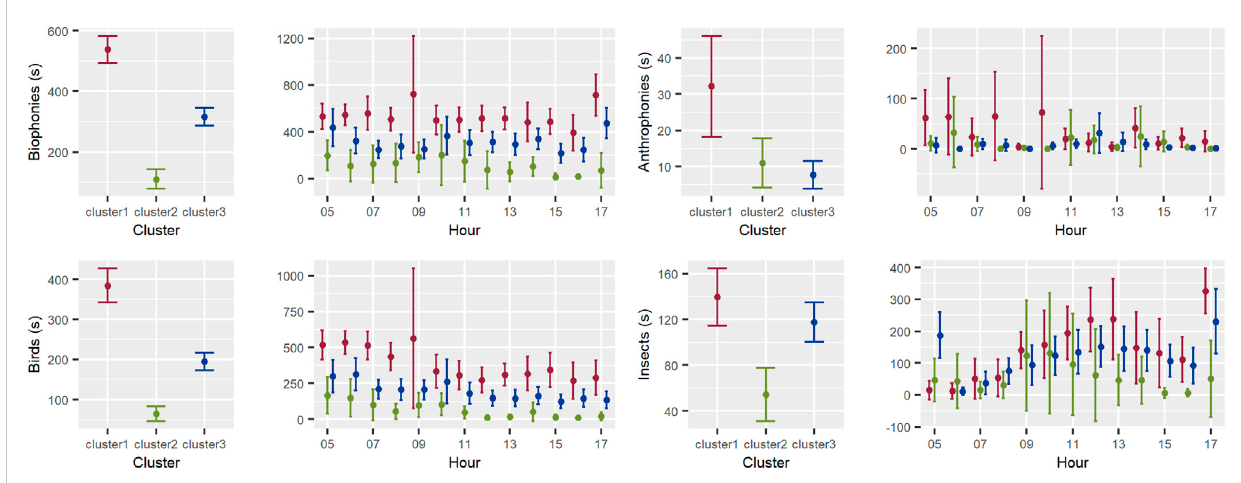
Distributionperhourofthemeantimeinone-minutesegmentsoccupiedbybiophonies(B1),birds(B2),insects(B3),andanthrophonies(B4)inevery cluster. Lines represent 95% con fi dence intervals for the